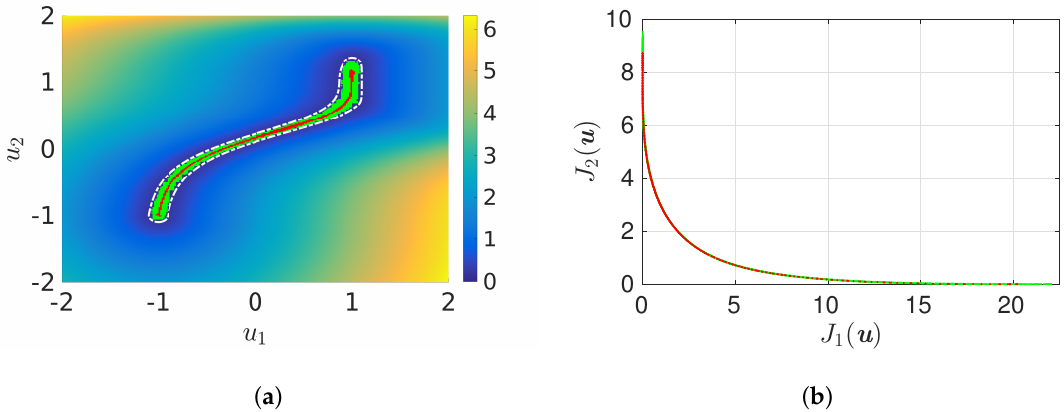
Figure 4. Exact and inexact solutions ( P S and P S , κ ) for a simple example with J : R 2 → R 2 , cf. [66] for details. ( a ) The sets P S and P S , κ (for a random error with κ = ( 0.01,0.01 ) (cid:62) ) are shown in red and green, respectively. The background is colored according to the optimality condition (cid:107) q ( u ) (cid:107) , which has to be zero for all substationary points. The dashed white line shows the error bound as derived in Theorem 2. ( b ) The corresponding Pareto